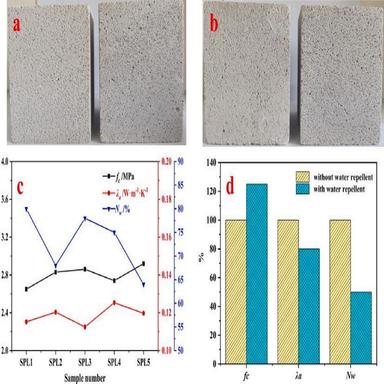
Testing samples prepared from molybdenum tailings: (a) Non-waterproof samples, (b) Waterproof samples, (c) Performance of the samples without waterrepellents, (d) Performance comparison of the samples with and without water-repellents.